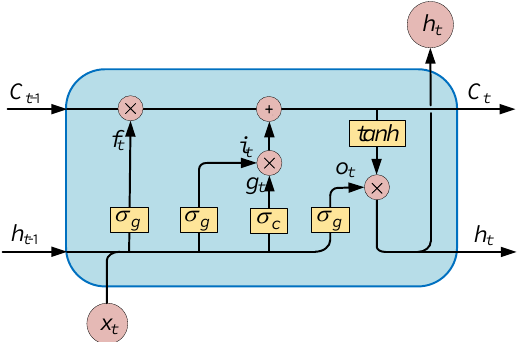
Figure 8. Structure of Uni-LSTM